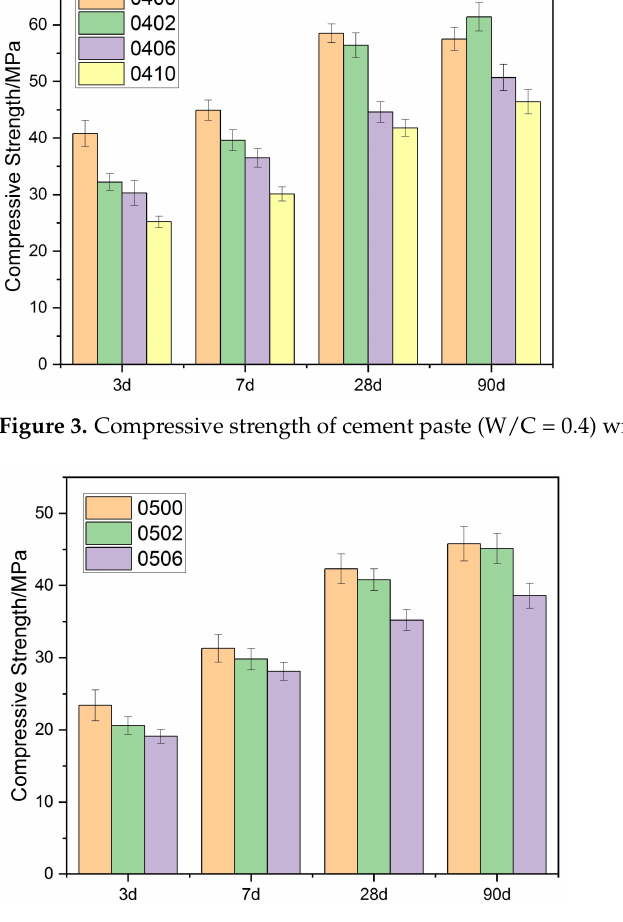
Figure 4. Compressive strength of cement paste (W/C = 0.5) with PEG-600.